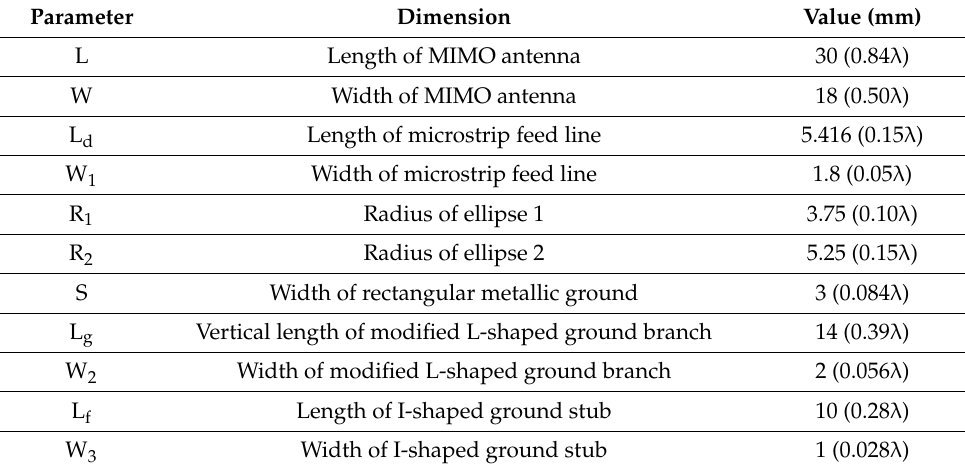
Table 1. Dimensions of the proposed MIMO antenna structure (f = 4 GHz).